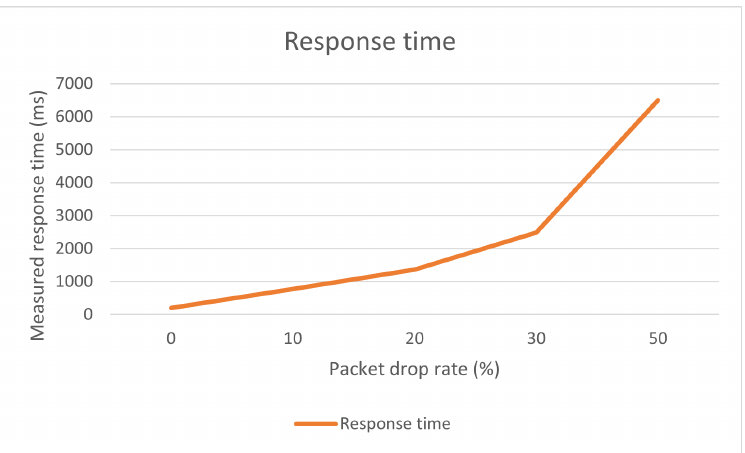
Figure 5. Response times from a cloud server to the edge device in relation to differing packet drop rates.